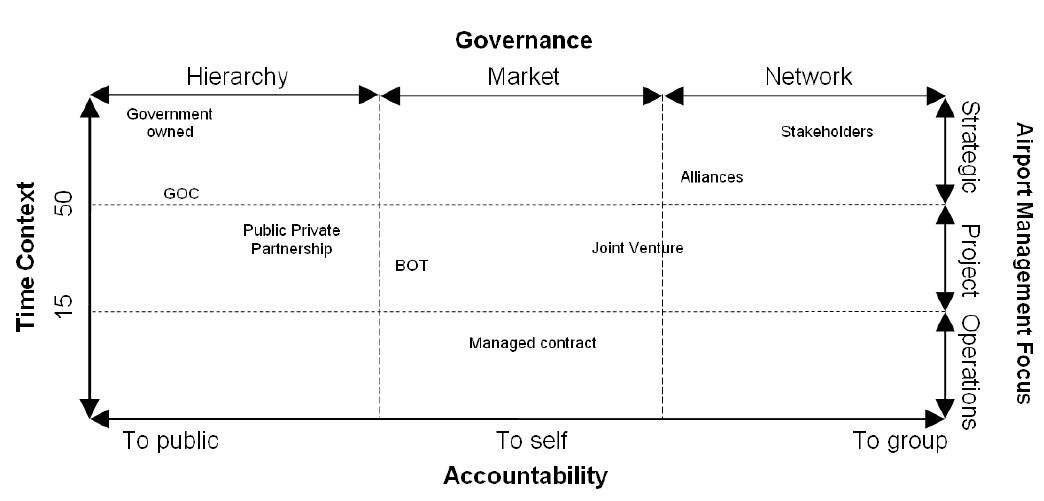
Figure 1. Focus, governance and accountability framework for airport privatisation